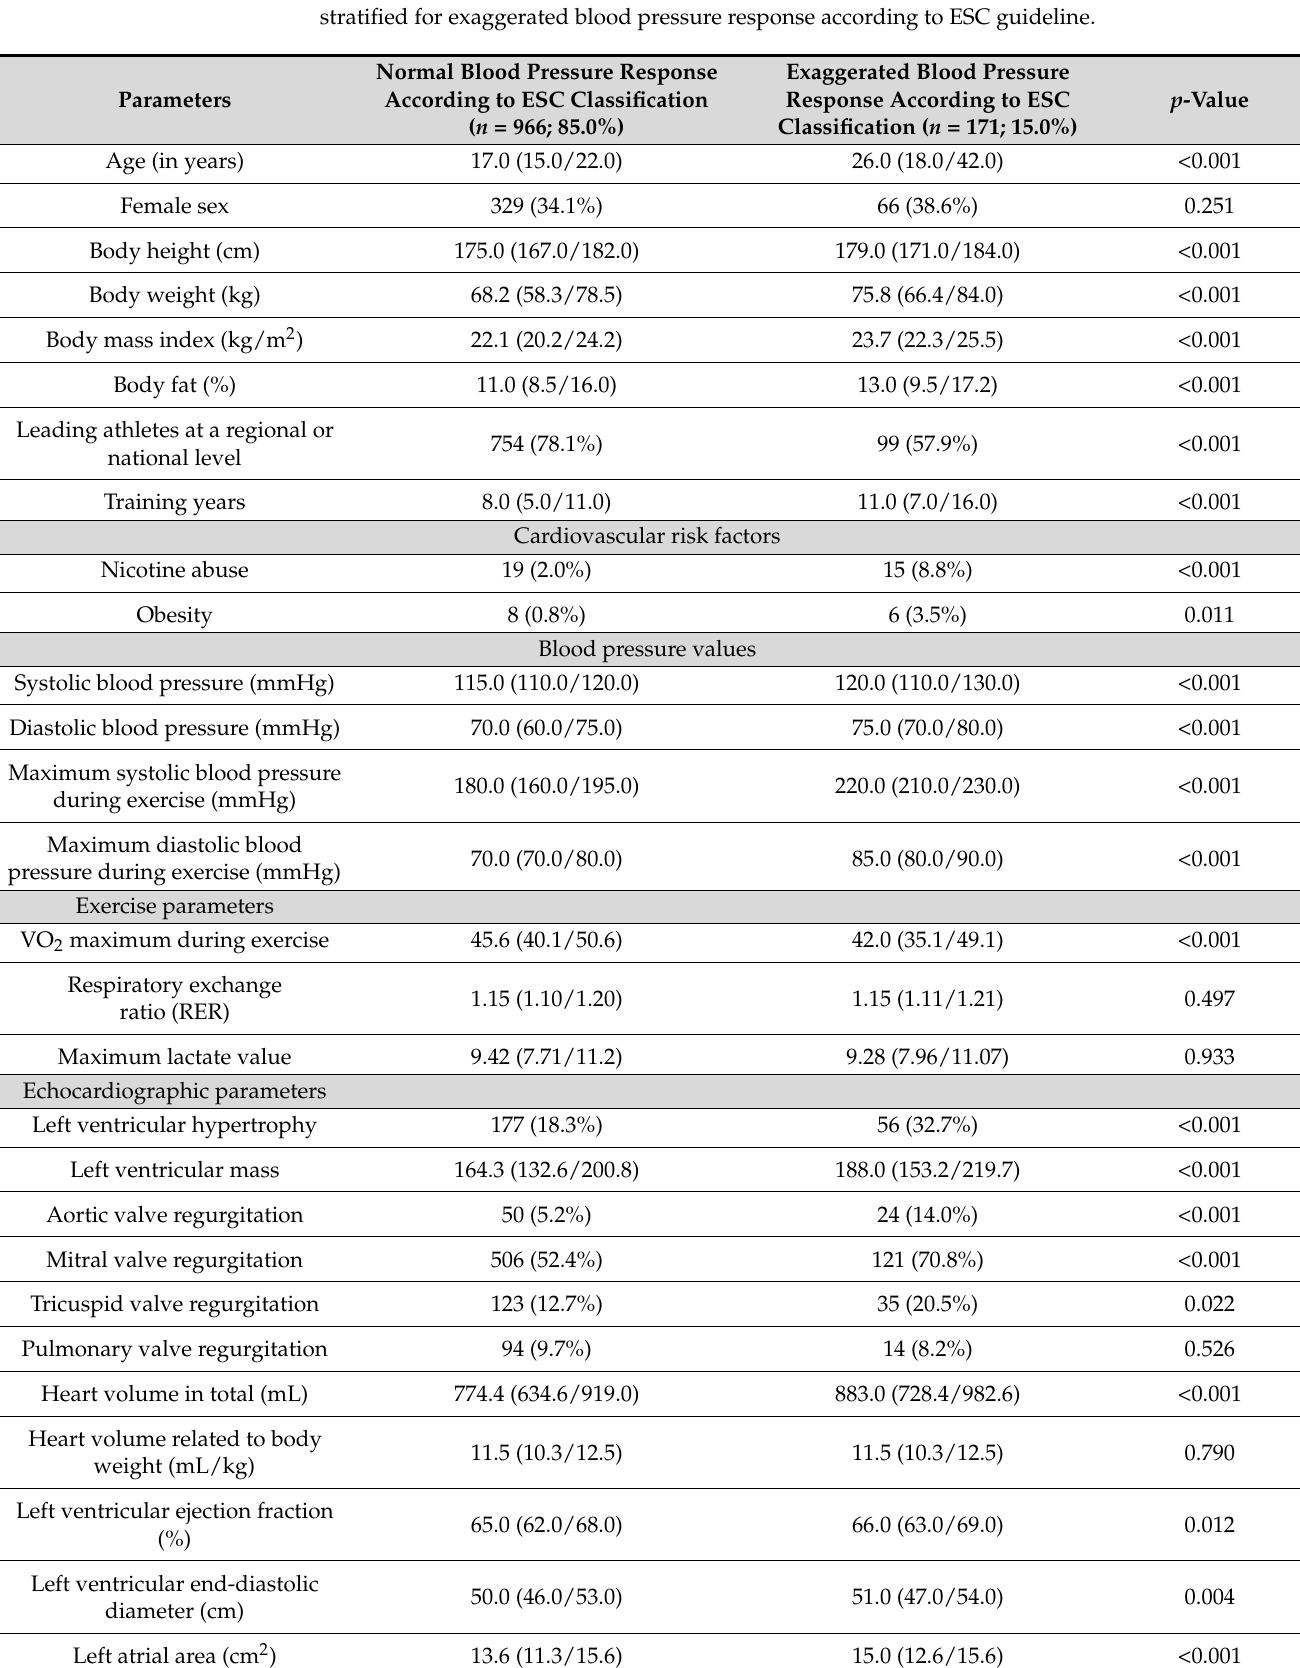
Table 2. Patient characteristics of the 1137 examined athletes without known arterial hypertension stratified for exaggerated blood pressure response according to ESC